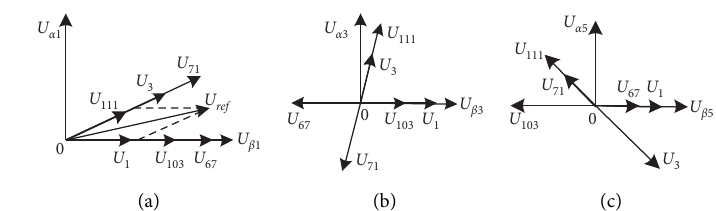
Figure 5: NSV-SVPWM vector synthesis: (a) Fundamental wave subspace. (b) The 3rd harmonic subspace. (c) The 5th harmonic subspace.